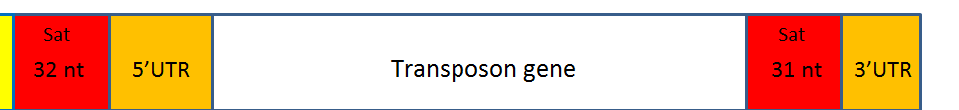
Figure 3. Scheme of a complete C. elegans Helitron. All satellites in Fam_46_32_6, with a 31 nt repeat, are part of Helitron1_CE sequences. The whole length of complete Helitrons varies in each case, between 7115 and 8956 nt. It is represented in a simplified way in this drawing. At the left, there is a short satellite with a repeat length of 15 nt (in yellow). Details of each region are given in Table 2.